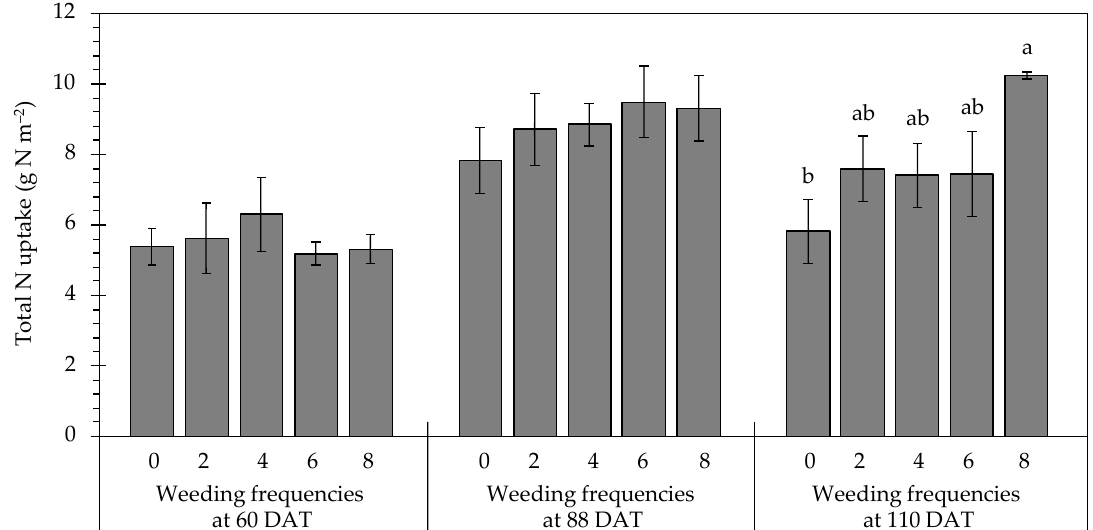
Figure 4. Effect of weeding frequencies on total nitrogen uptake of rice and weeds at 60, 88, and 110 DAT (days after transplantation). Bars indicate standard deviation ( n = 4). In total nitrogen uptake, values followed by different letters are statistically different at p < 0.05 based on Tukey’s HSD test. The frequency of mechanical weeding until 49 DAT was 0, 2, 4, 6, and 8 times.